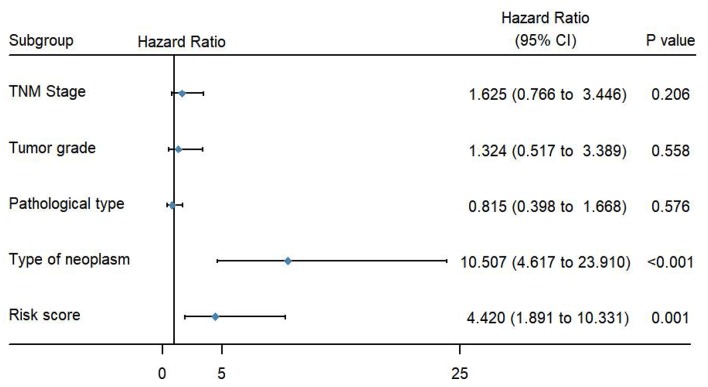
Forest map of clinical characters in multivariate analysis. The coordinate of the blue diamond represents the odds ratio. Multivariate Cox regression analysis was performed. Subgroup with a value of p < 0.05 was considered statistically significant.